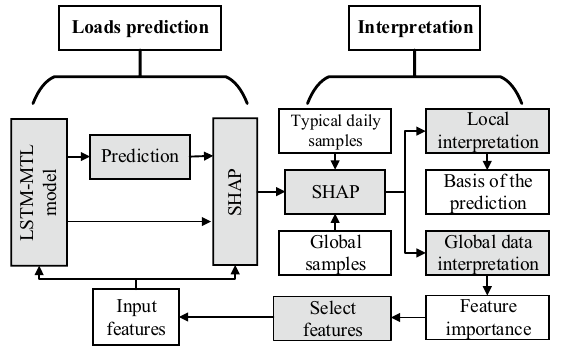
Fig. 3 Explainable framework of load forecasting for RIES based on